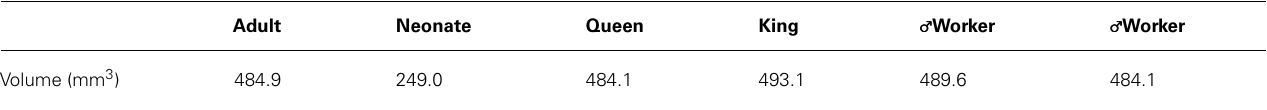
Table 3 |Volumes of the whole brain in male adult and neonatal postmortem specimens, and four subjects; a female adult breeder (queen), a male adult breeder (king), two male non-breeders ( ♂♂♂